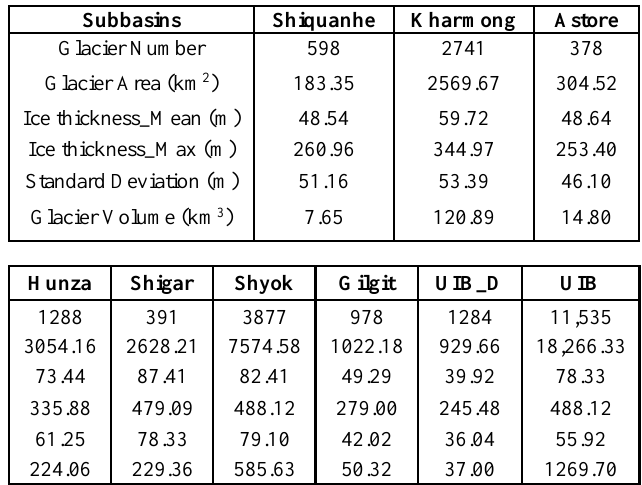
Table 2. Detailed glacier information of UIB subcatchments The calculated ice thickness distribution values in the UIB